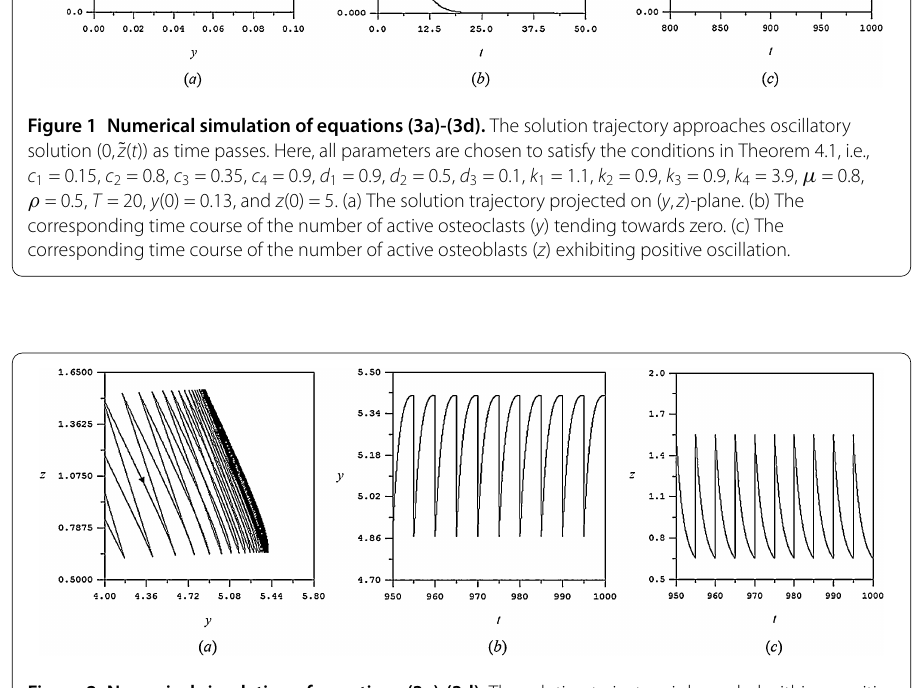
Figure 2 Numerical simulation of equations (3a)-(3d). The solution trajectory is bounded within a positive range as time passes. Here, all parameters are chosen to satisfy the conditions in Theorem 5.1. Here, c 1 = 0.5, c 2 = 0.9, c 3 = 0.35, c 4 = 0.9, d 1 = 0.95, d 2 = 0.05, d 3 = 0.5, k 1 = 1.2, k 2 = 0.95, k 3 = 0.9, k 4 = 3.9, μ = 0.9, ρ = 0.1, T = 5, y (0) = 0.1, and z (0) = 2. ( a ) The solution trajectory projected on ( y , z )-plane. ( b ) The corresponding time course of the number of active osteoclasts ( y ) and ( c ) the corresponding time course of the number of active osteoblasts ( z ).